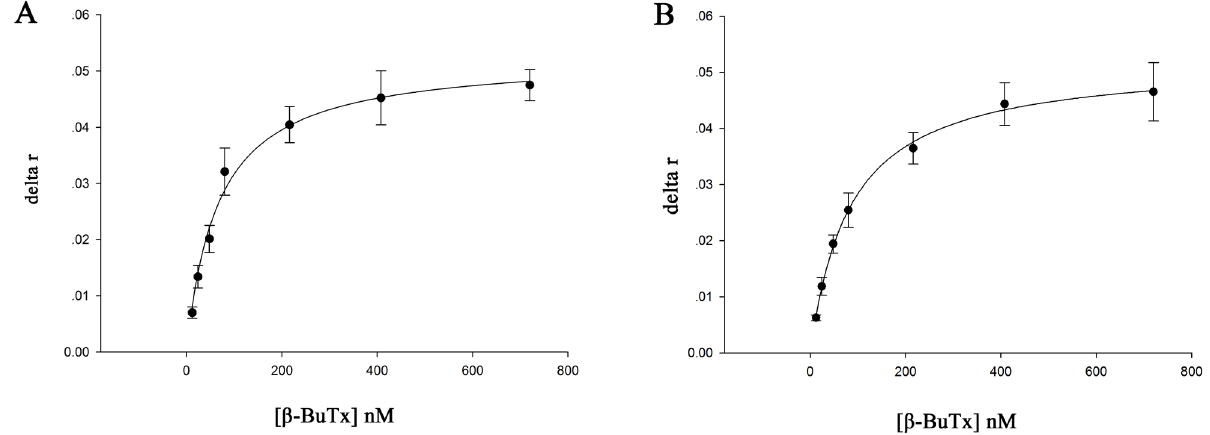
Figure 2. Dissociation constant (K d ) measurements by fluorescence anisotropy. A) b B-1; B) b B-20. Two nM of fluorescein labeled aptamers were titrated with increasing concentrations of b -BuTx. The anisotropy change (delta r) was the anisotropy of the initial fluorescein labeled aptamer subtracted from the anisotropy value at each b -BuTx concentration. Non-linear regression analysis revealed the K d of b B-1 was 65.9 6 7.8 nM, and the K d of b B-20 was 83.8 6 4.3 nM. Error bars represent standard deviations from three repeated experiments.